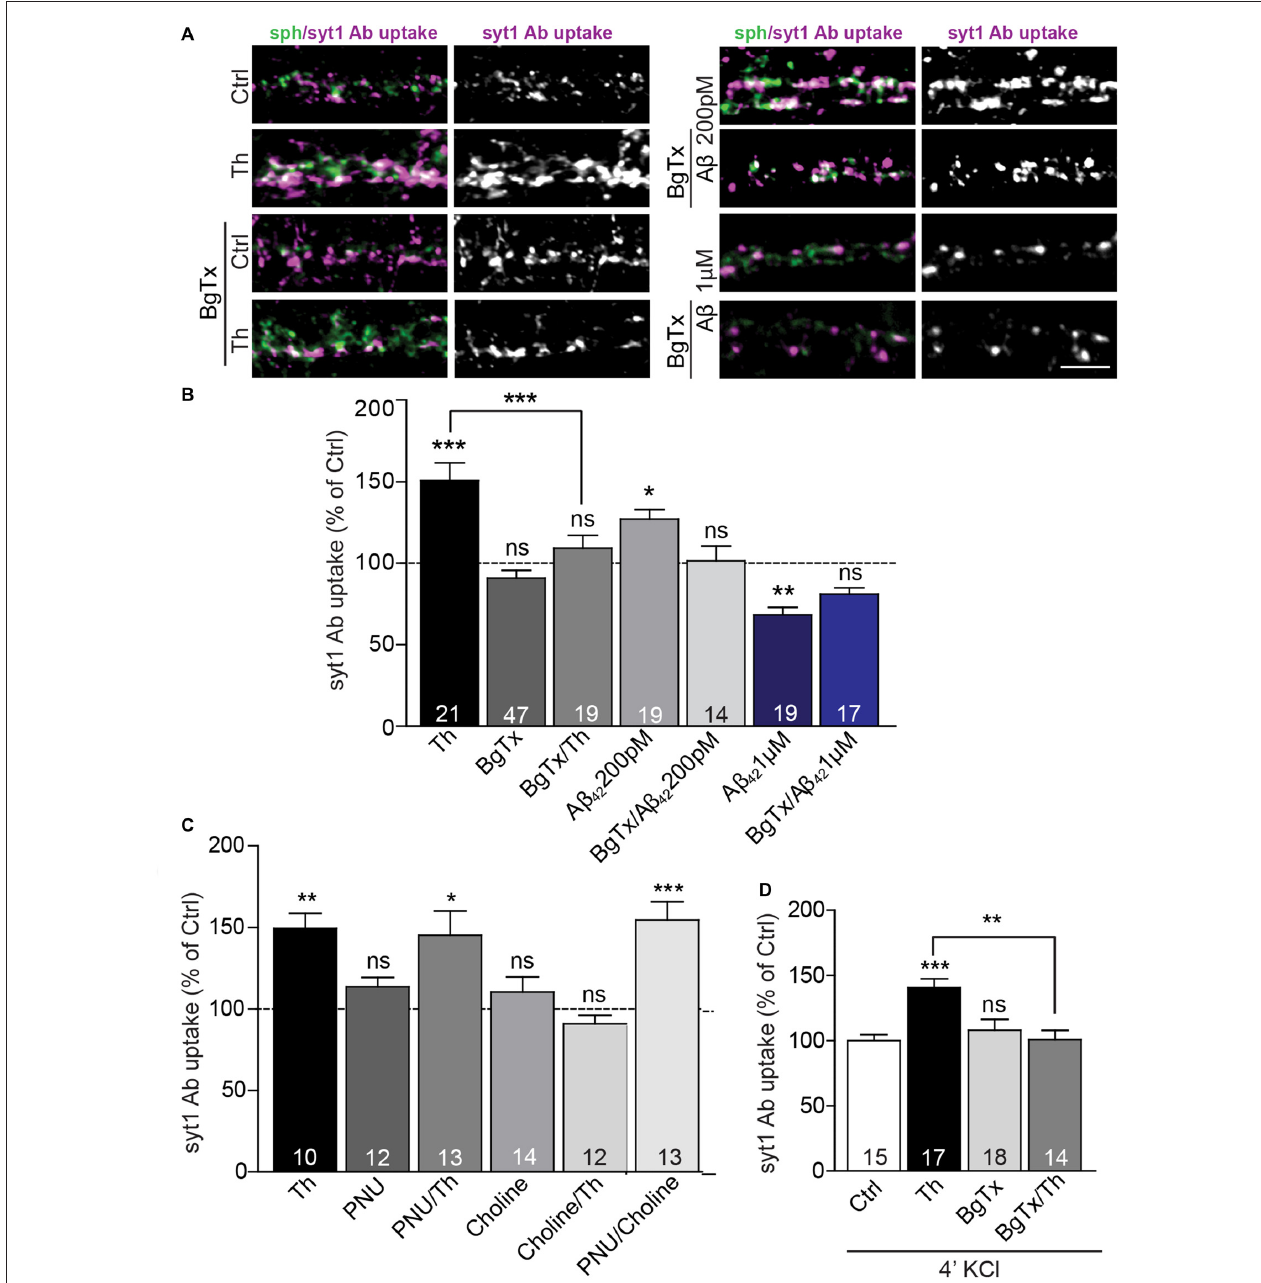
FIGURE 4 | Picomolar A β acts via α 7nACh receptors. (A) Representative images of syt1 Ab uptake from Th-, A β 42 200 pM or A β 42 1 µ M-treated neurons pre-incubated with BgTx to investigate the effect of α 7nAChR. (B) Quantification of syt1 Ab uptake from (A) . Numbers within columns indicate numbers of analyzed cells from two (Th; A β 42 200 pM) or three (A β 42 1 µ M) cell culture preparations. (C) Statistical analysis of syt1 Ab uptake from cortical neurons treated with control, Th or/and ortho- and allosteric modulators of α 7nACh receptors. (D) Quantification of depolarization-induced syt1 Ab uptake after control, Th and/or BgTx application. The numbers within bars (C,D) indicate the number of analyzed cells obtained from two separate cell culture preparations. In all graphs the values are expressed as the mean ± SEM. Statistical significance was evaluated by Kruskal-Wallis test followed by Dunn’s multiple comparison test (B,C) or one-way ANOVA with Bonferroni post hoc test (D) ; ∗ p < 0.05, ∗∗ p < 0.01, ∗∗∗ p < 0.001. Scale bar 5 µ m.